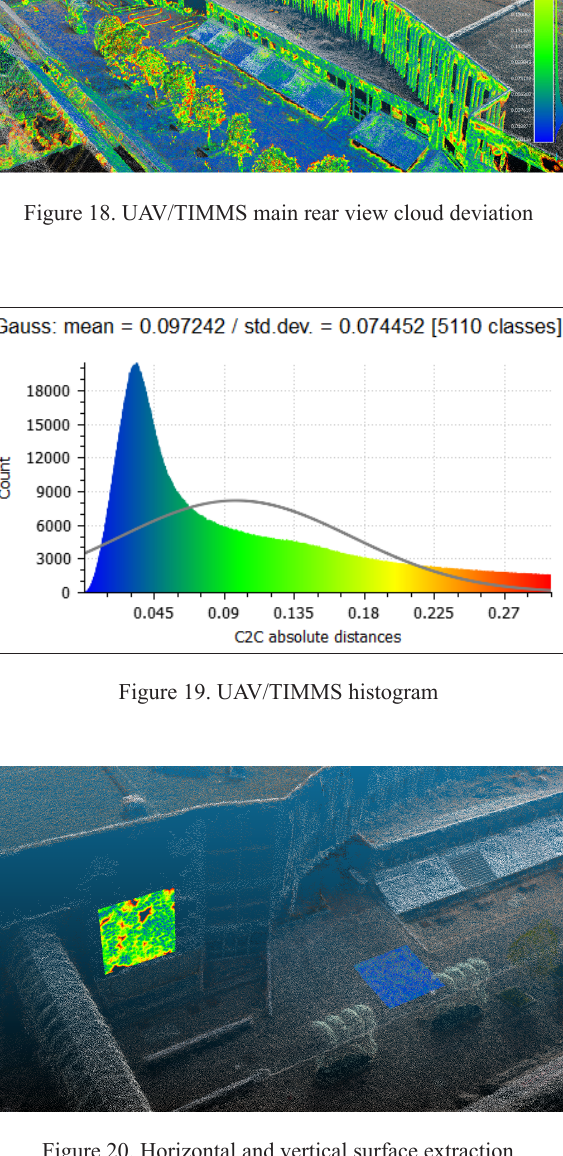
Figure 20. Horizontal and vertical